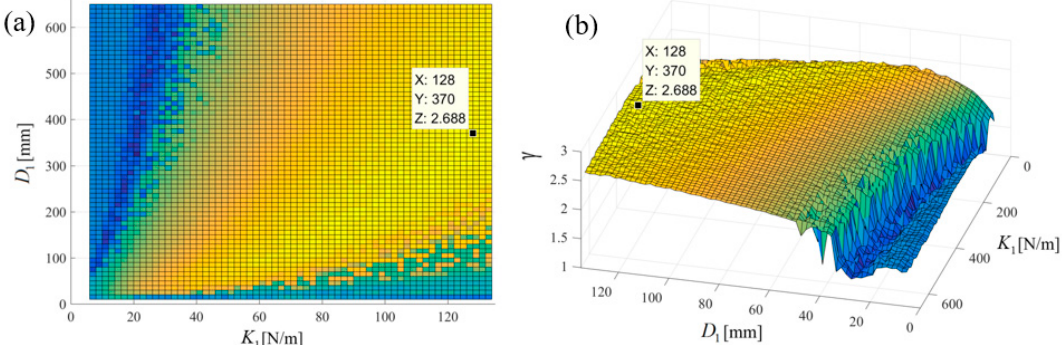
γ D and K of the NPEHS-1: ( a ) along with different 1 1 γ along with different 1 D and 1 K of the NPEHS-1: ( a )